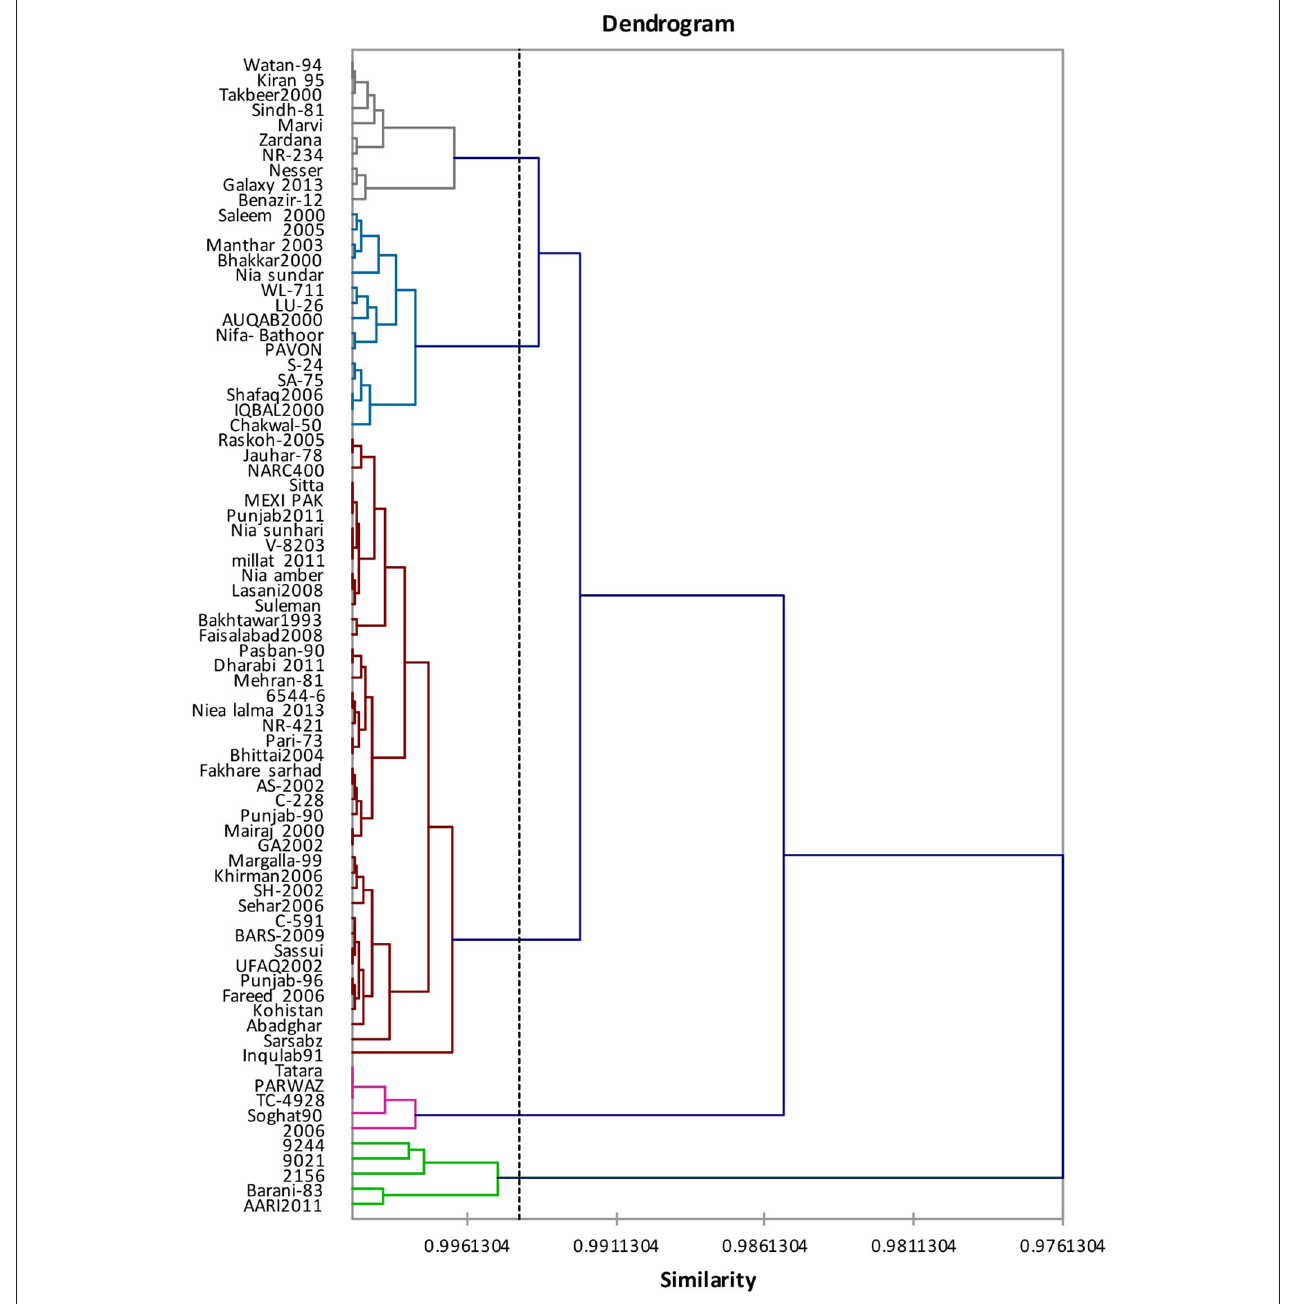
FIGURE 2 | Tree diagram based on four traits regarding single characterization system for different wheat